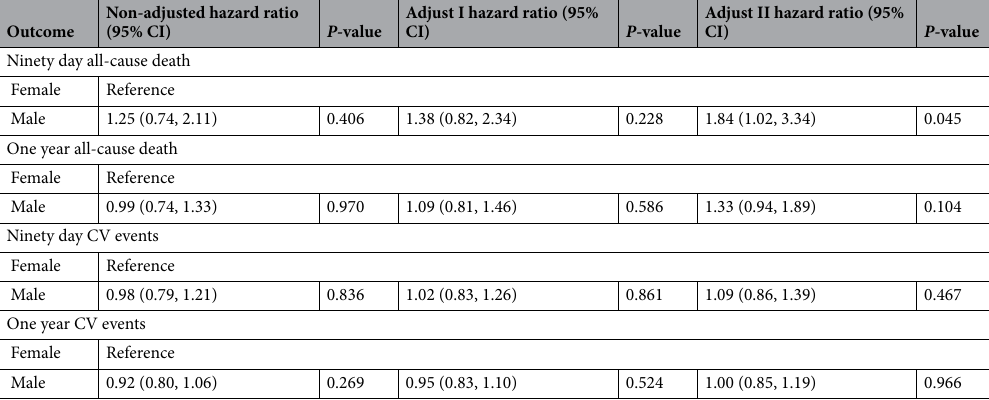
Table 4. Results of a multivariate Cox proportional hazards model for the effect of gender on outcome events in patients with HFmrEF. Adjust I model adjust for: age. Adjust II model adjust for: age; body mass index; current smoker; current drinker; hypertension; hyperlipidemia; diabetes mellitus; coronary heart disease; atrial fibrillation; previous stroke; chronic obstructive pulmonary disease; renal insufficiency; New York Heart